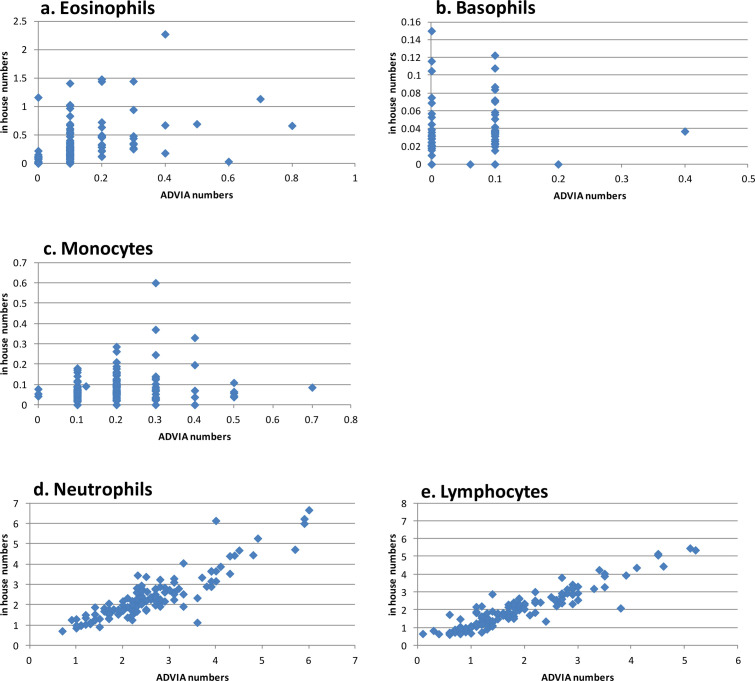
Correlation (r) of white blood cell classification by the ADVIA-120® with the 200-cell manual differential method.Eosinophils (a. r = 0.41), Basophils (b. r = 0.153), Monocytes (c. r = 0.04), Neutrophils (d. r = 0.90), and Lymphocytes (e. r = 0.93). Distances along the axes are unit-less, therefore the positions of the points in the plots are relative distances from one another rather than absolute differences read in these units.